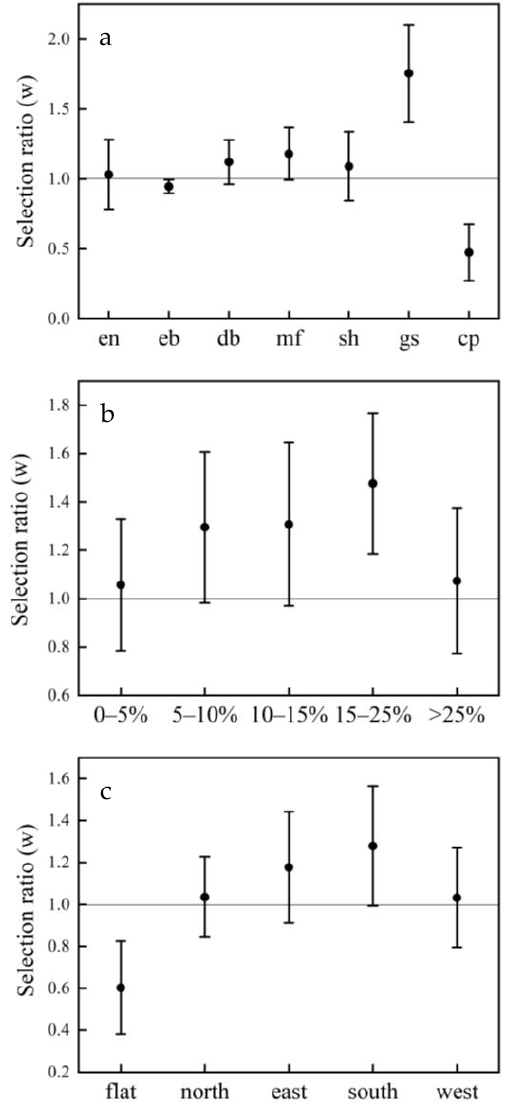
Figure 6. Average selection ratios with 95% confidence intervals for land cover ( a ), slope ( b ), and aspect ( c ) for the western United States. Note: en–evergreen needleleaf forests; eb–evergreen broadleaf forests; db–deciduous broadleaf forests; mf–mixed forests; sh–shrublands; gs–grasslands; and cp–croplands.